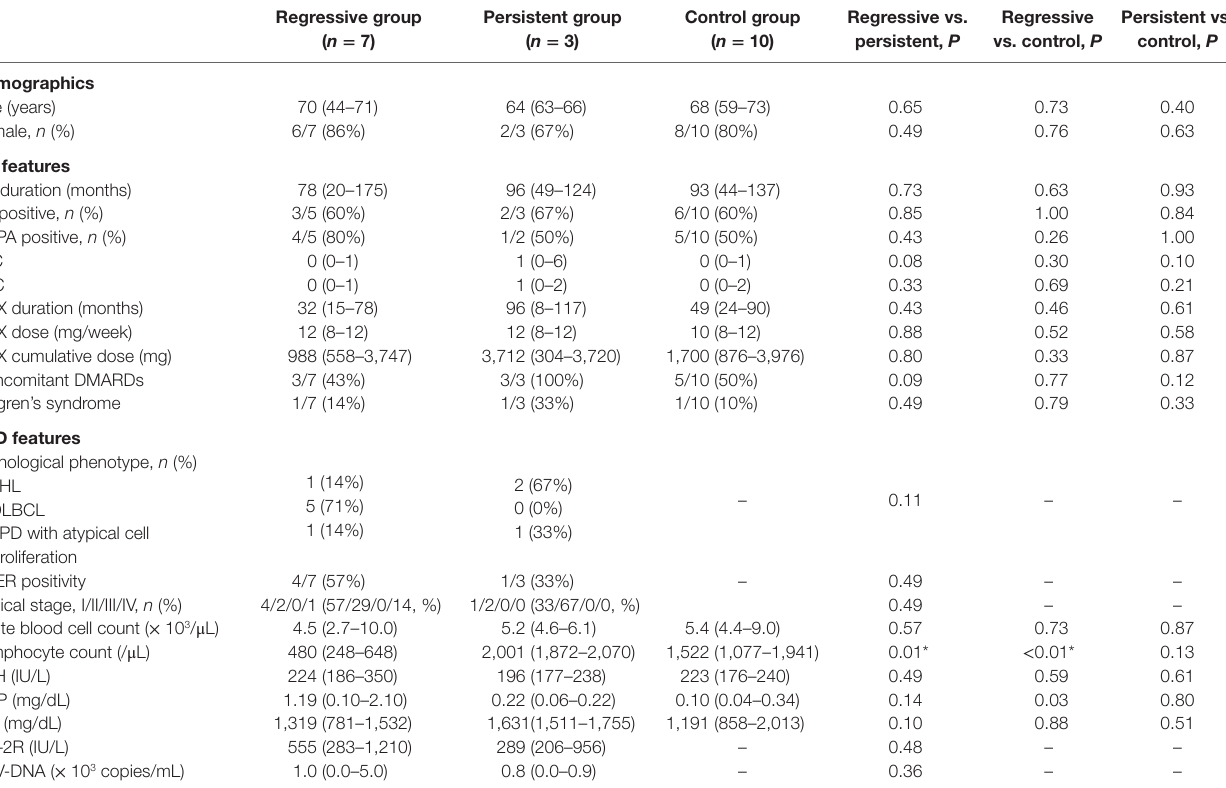
TaBle 2 | Characteristics of LPD and control RA patients for whom flow cytometric analysis of whole blood sample and cytokine analysis of serum sample were conducted. regressive group ( n =